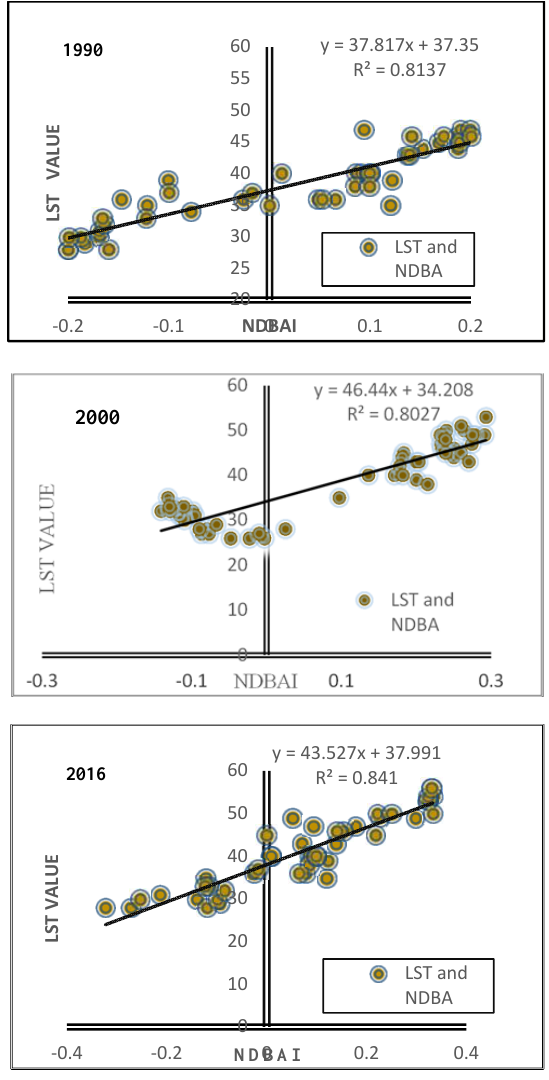
Figure 10. Correlation between NDBAI and LST in the period of the study (1990, 2000 and 2016).